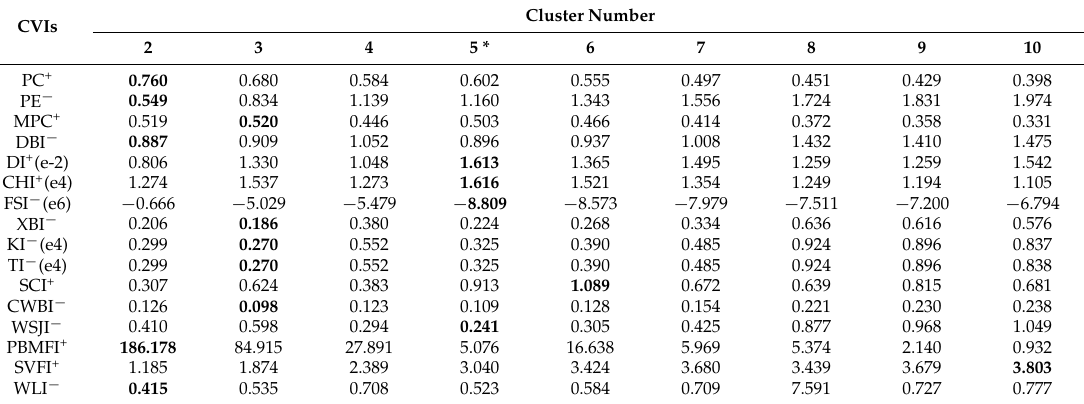
Table 7. Variations of the 16 CVIs with cluster numbers ranging from 2 to 10 for the FLC1 image.